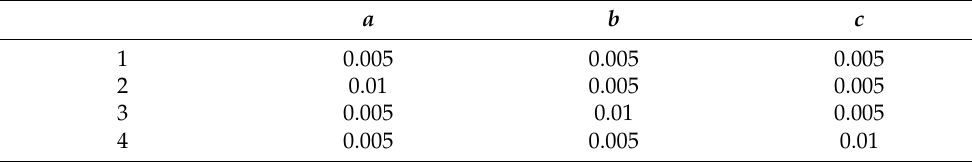
Table 4. Four combinations of a , b , and c .